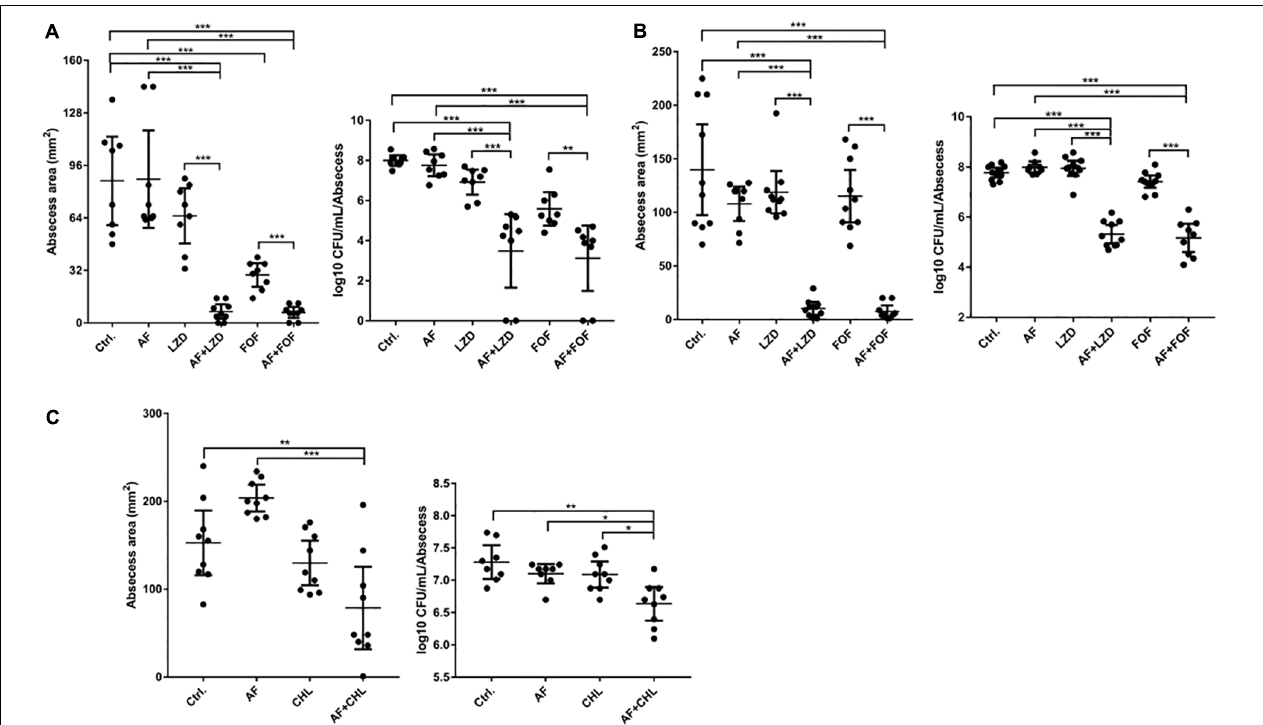
FIGURE 5 | AF and antibiotic mono- and combinatorial therapy in a murine cutaneous abscess model using female CD-1 mice. Bacterial strains were injected subcutaneously and treated 1 h post-infection with either saline/DMSO/Tween-80 (control), AF, antibiotics, or antibiotic-AF combinations. AF concentrations for all conditions were as follows: 0.5 mg/kg for S. aureus LZB1 (A) and ATCC43300 (MRSA) (B) , and 5 mg/kg for E. faecalis ATCC29212 (C) . Infected and inflamed tissue was measured 2 days post-infection and pus-containing abscess lumps were excised to determine CFU. Abscess sizes are shown in the left panel and counted CFU/ml/abscess data is expressed in the right panel. (A,B) S. aureus LZB1, LZD 5 mg/kg, and FOF 20 mg/kg, respectively. (C) E. faecalis ATCC29212, CHL 20 mg/kg. All experiments were performed at least three times with 2–4 mice/group. Mean total abscess size (mm 2 ) ± the standard error of the mean (SEM). Statistical analysis was performed using one-way ANOVA, Kruskal–Wallis test with Dunn’s correction (two-sided). The asterisk indicates significant differences between two groups ( ∗ p < 0.05; ∗∗ p < 0.01; ∗∗∗ p <